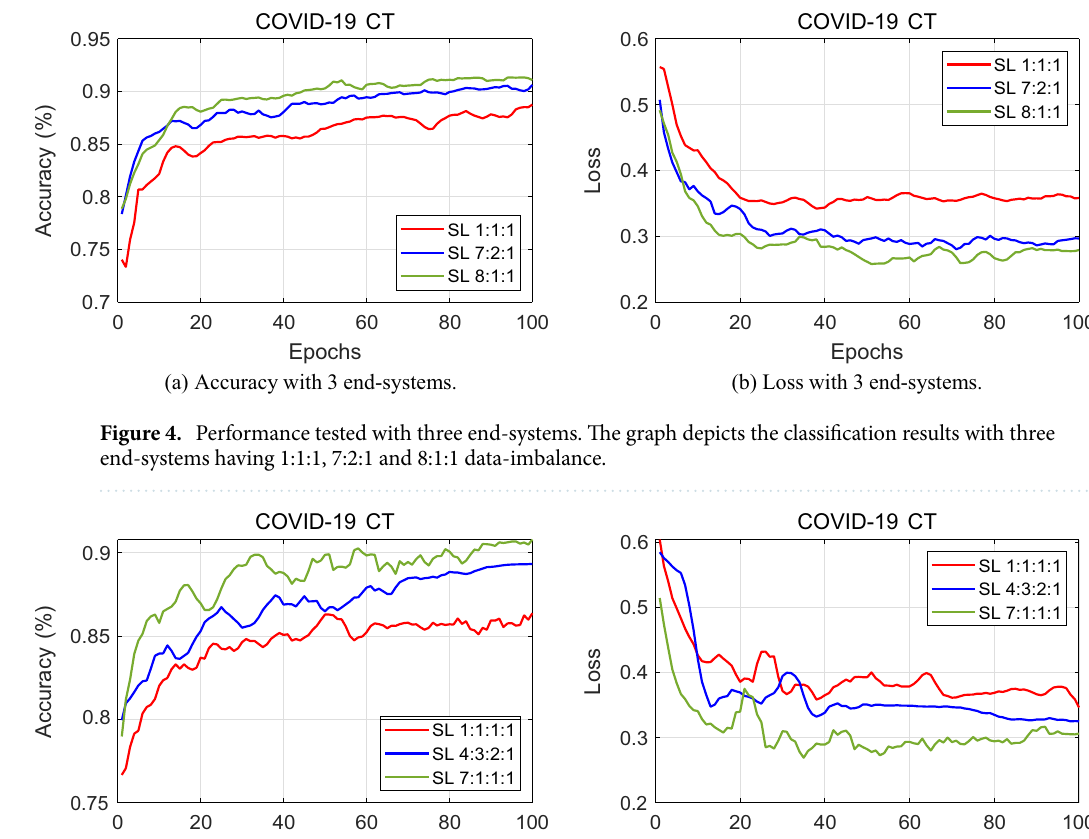
.smetsys-dne4htiwssoL)b(.smetsys-dne4htiwycaruccA)a( Figure 5. Performance tested with four end-systems. The graph depicts the classification results with four end- systems having 1:1:1:1, 4:3:2:1 and 7:1:1:1